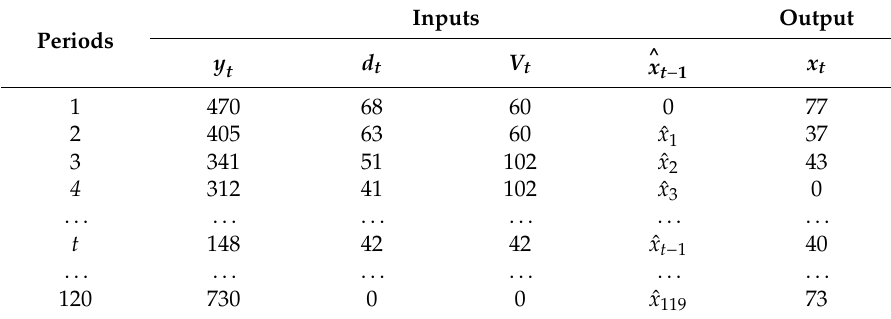
Table 3. Sample input and output values for the deep neural network (DNN) model.